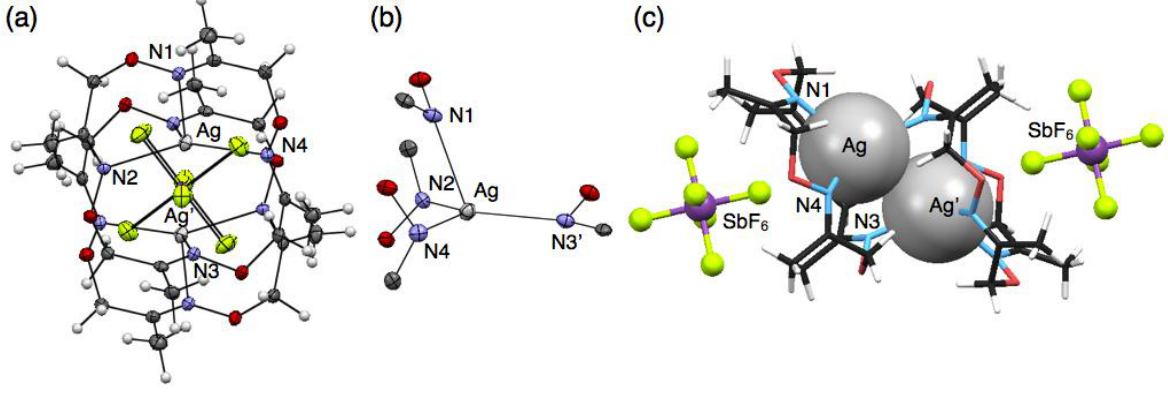
( 1 ) ](SbF ) . ( a ) A top view; and ( b ) the coordination 2 2 6 2